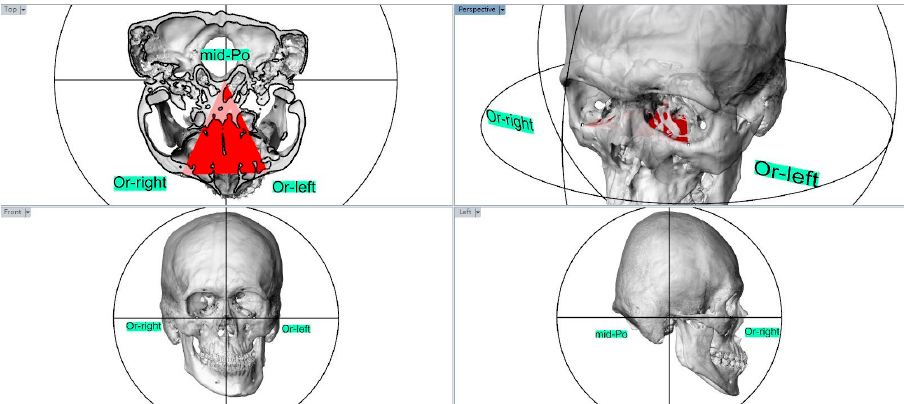
Figure 1. The head orientation was paralleled to the Frankfort horizontal (FH) line as the horizontal reference, and the FH plane was constructed with a landmark of middle point of both Porion (mid-Po) and bilateral Orbitle (Or-right and Or-left).